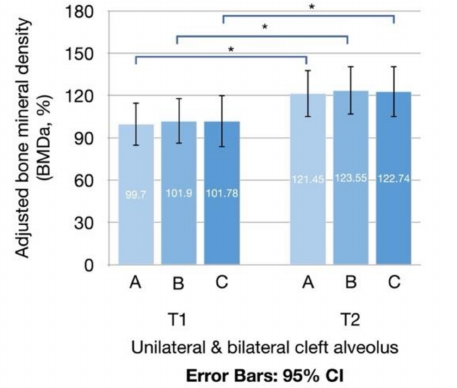
Figure 4. Error bars of adjusted bone mineral density (BMD a ) of grafted tissue at T1 and T2. Stars indicate significant differences in BMD a between T1 and T2: *, p <